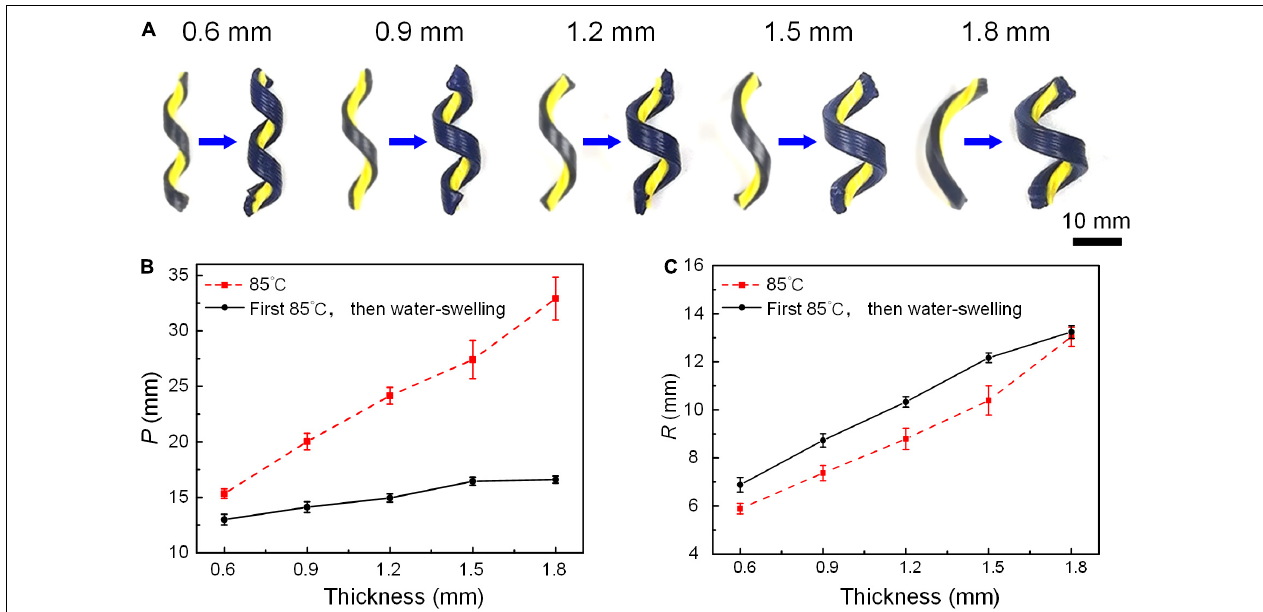
FIGURE 6 | The effect of the PU layer thickness printed at an oblique angle of 45 ◦ on spiral deformation of the PU-SMPVC bilayer structures. (A) Images of spiral deformation of the PU-SMPVC bilayer structures generated in 85 ◦ C and the shifted shapes induced by water-swelling after thermally induced deformation. The values of pitch (B) and radius (C) of thermally induced spiral deformation and under the combined action of water and heat (85 ◦ C).